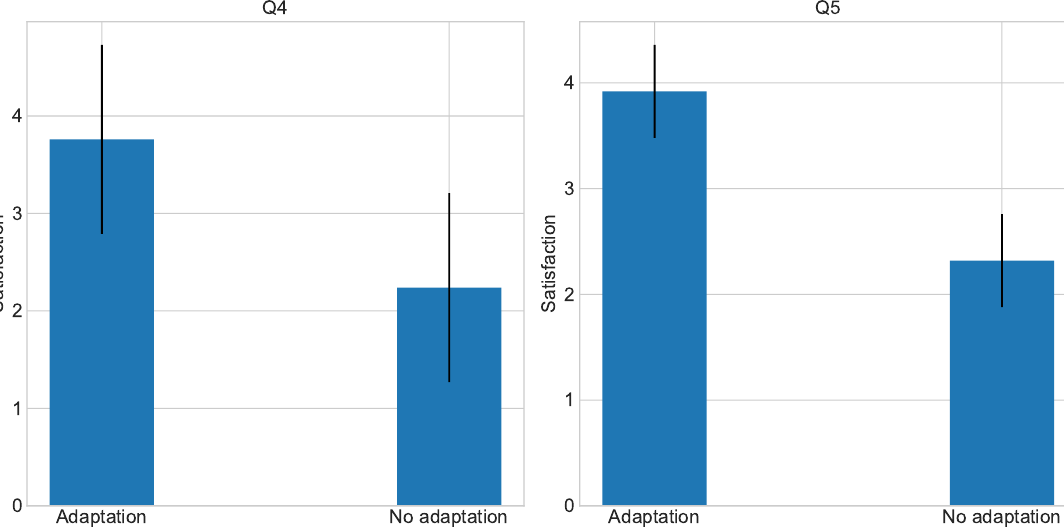
Figure 5. Results for Q4 and